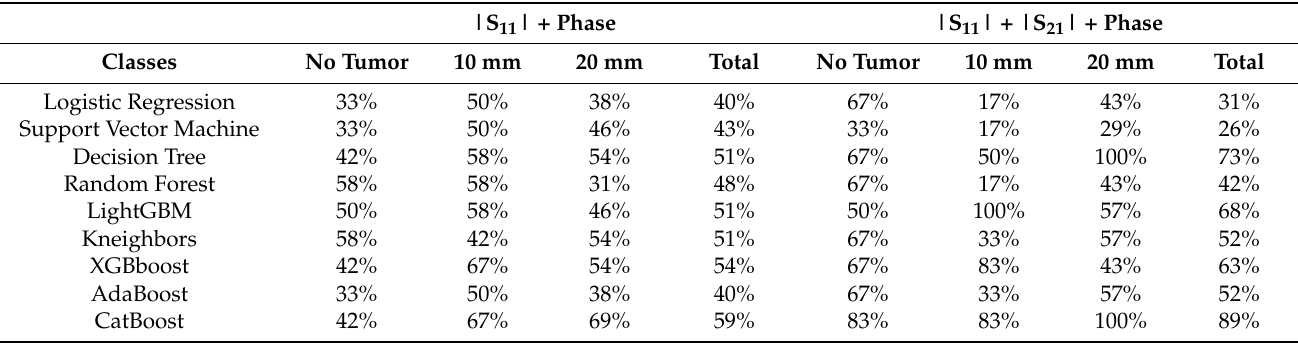
Table 4. Classification accuracy of different algorithms for both